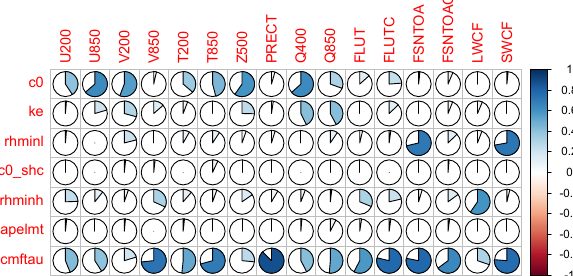
Figure 3. Sensitivity analysis results from the Sobol method. The total sensitivity in Eq. (8) is denoted by the size of the color area. The total sensitivities of ke, c0_shc, and capelmt are less than 0.5 in terms of each variable.